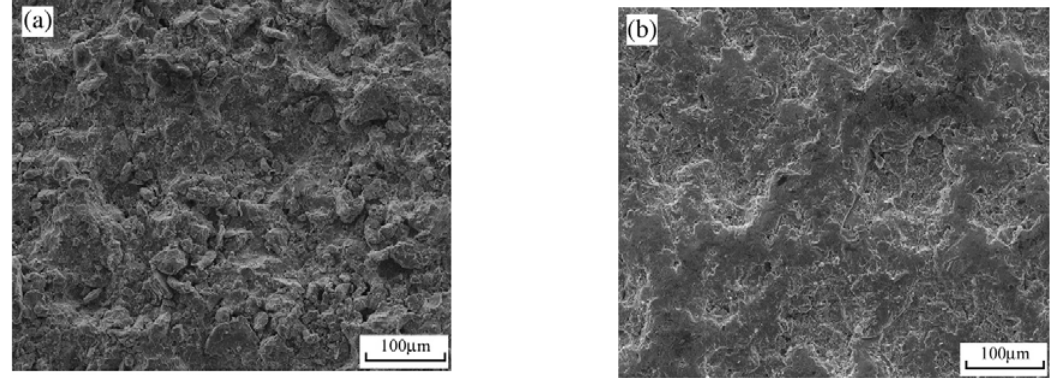
Figure 12: Surface morphology of as-sprayed NiCrAlY bond coating (a) and after shot-peened NiCrAlY bond coating